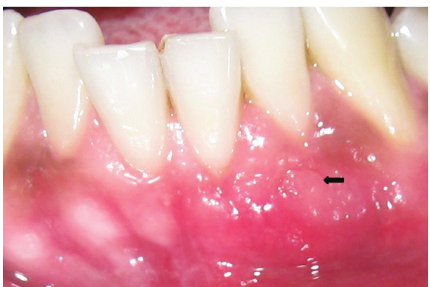
Figure 7: At 6-month followup the fenestration was completely covered and adequate root coverage of the recessed tooth was